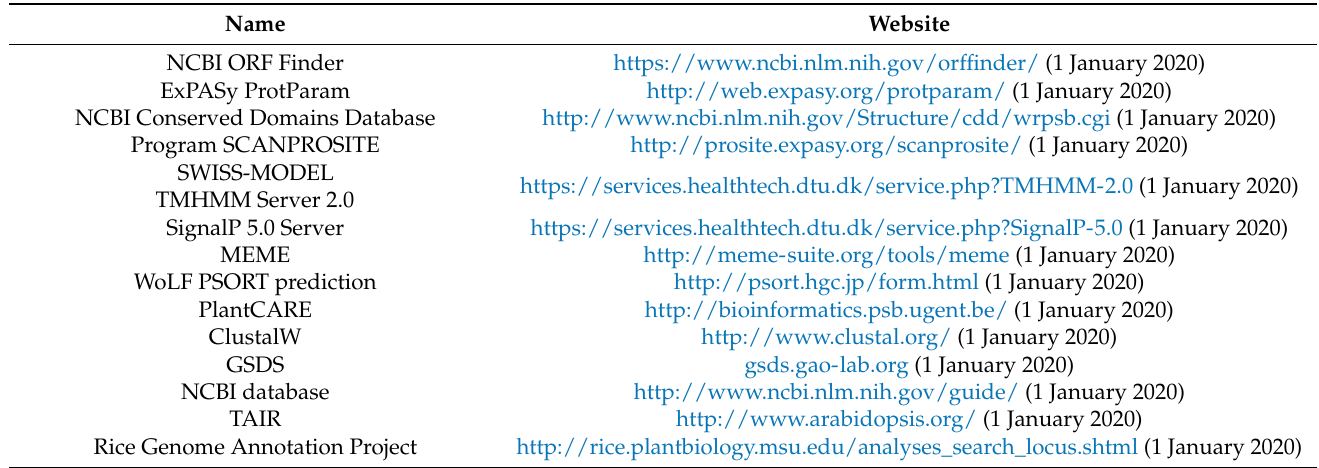
Table 1. Bioinformatics tools and